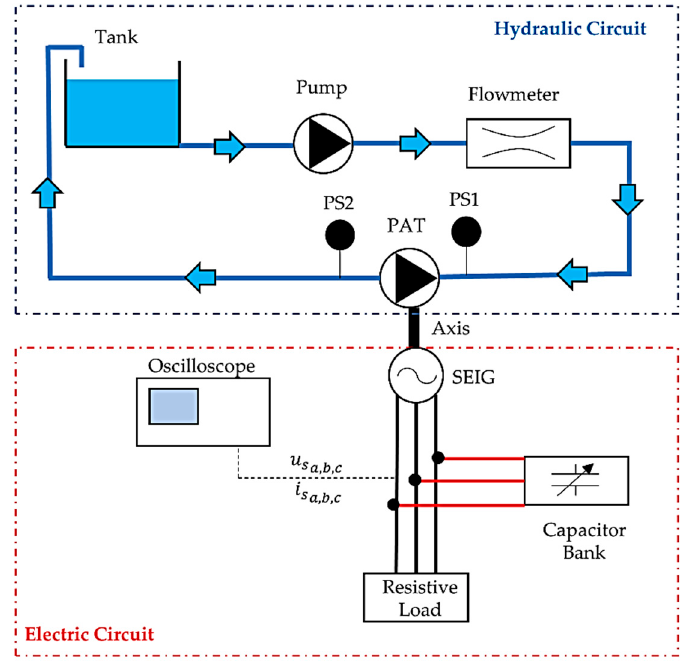
Figure 1. PAT + SEIG scheme. Hydraulic and electrical Figure 1. PAT+SEIG scheme. Hydraulic and electrical circuit.